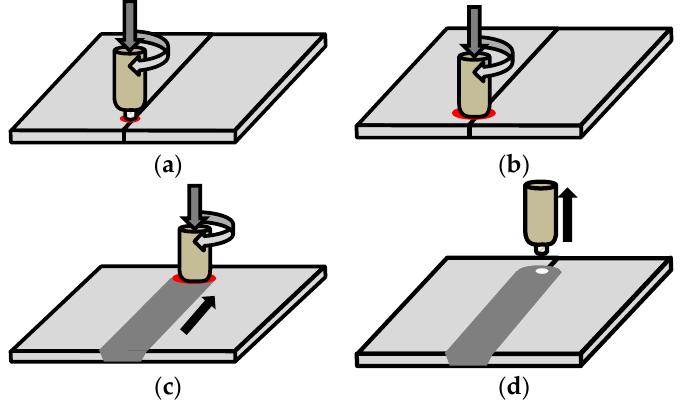
Figure 2. Schematic view of the FSW process: ( a ) plunging into material stage; ( b ) dwell stage; ( c ) welding stage; ( d ) end of welding and tool retraction stage.